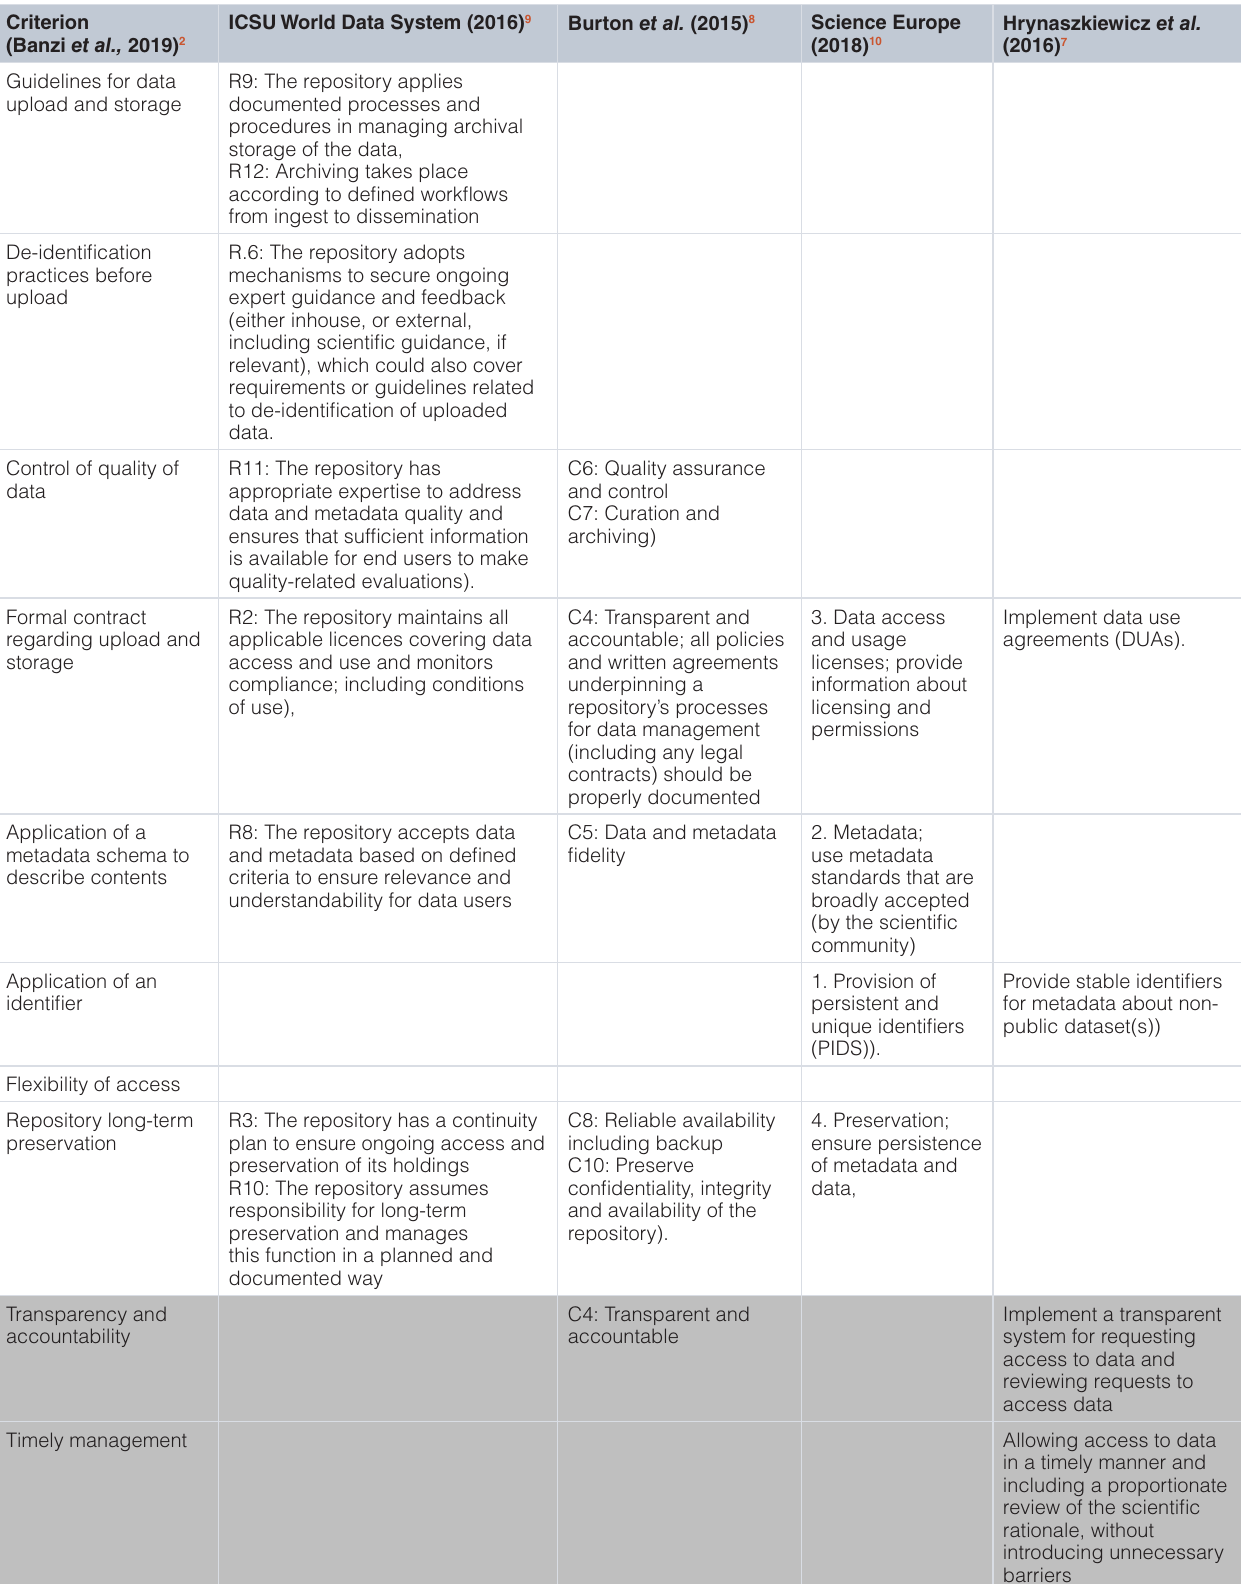
Table 3. Comparison between the Banzi quality criteria 2 and the other approaches. Grey: not considered by the Banzi criteria 2 . Criterion (Banzi et al., 2019)